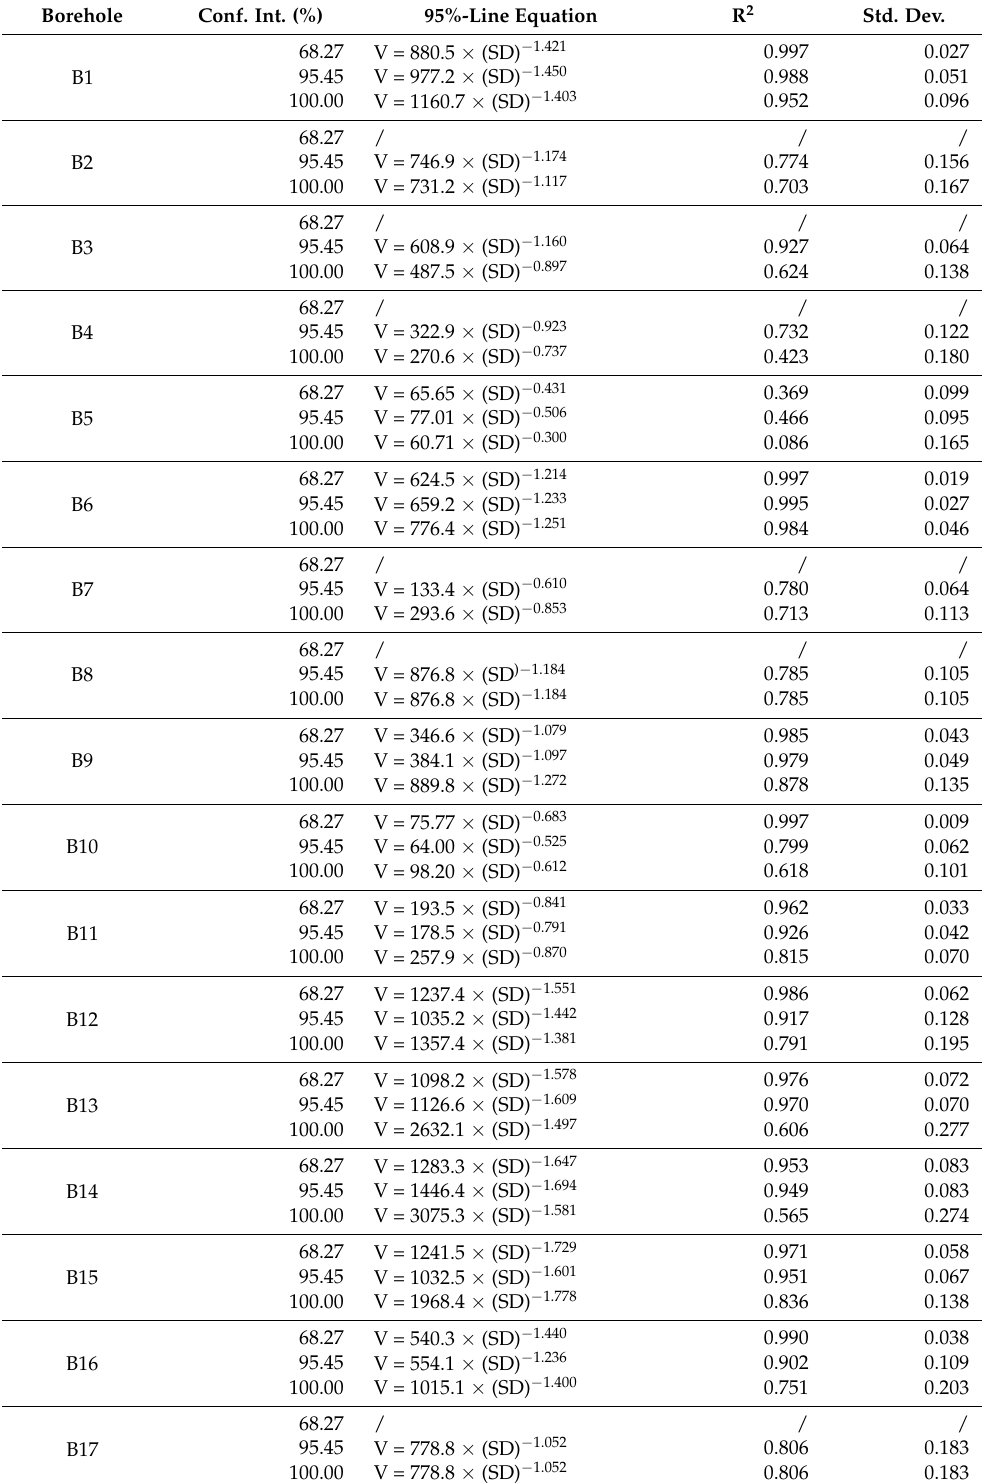
Table 6. Regression lines with 95%-line equations, coefficients of determination (R 2 ) and standard deviations for all 17 boreholes and different confidence